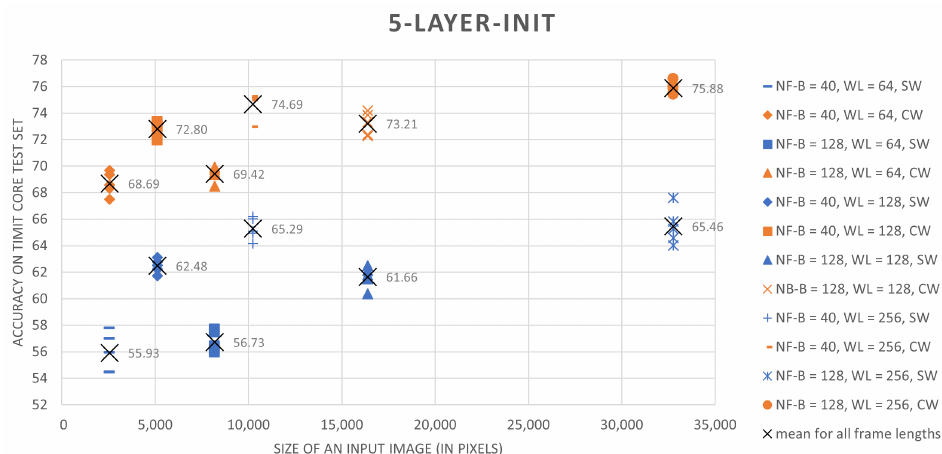
Figure 4. Classification accuracies for the initial 5-layer CNN architecture as a function of input image size and speech preprocessing